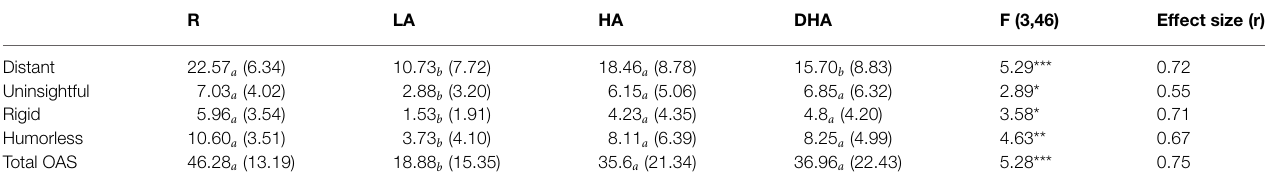
TABLE 1 | Means (and standard deviations) for total Observer Alexithymia Scale (OAS) scores and subscales for repressor (R), low-anxious (LA), high-anxious (HA), and defensive high-anxious (DHA) groups. Effect sizes (r) are reported for predicted differences between R and LA. R LA HA DHA F (3,46)